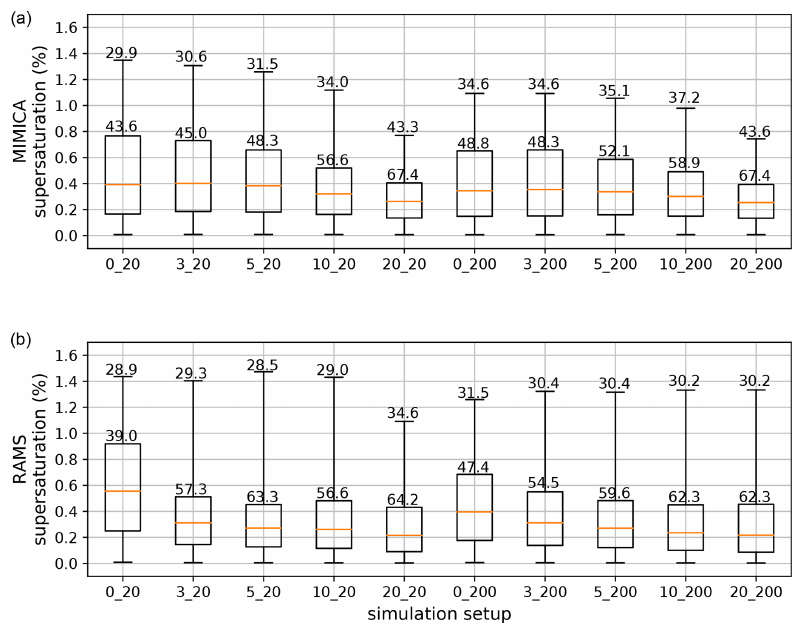
Figure 14. Supersaturation statistics shown for a set of cases initialized with a κ value of 0.4, simulated by MIMICA and RAMS. The statistics are calculated for a 20min period around 6h of simulation for all grid boxes with relative humidity > 100%. Lower and upper whiskers correspond to first and 99th percentiles, respectively. The numbers written in the figure are critical dry diameters that correspond to supersaturation 75th percentiles (upper limit of the box) and 99th percentiles. For figure clarity, the plot titles have been abbreviated; the first number refers to the accumulation mode and the second to the Aitken mode concentration in cubic centimetres, i.e. 0_20 refers to